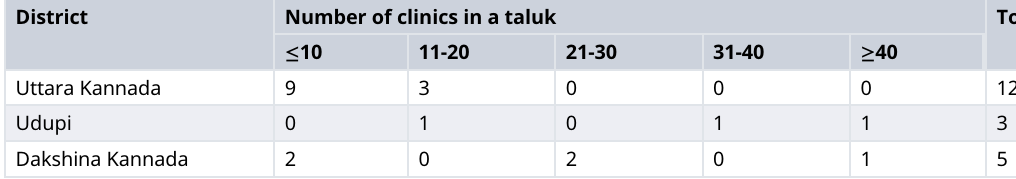
Table 2. Taluk-wise distribution of dental clinics stratified according to the 3